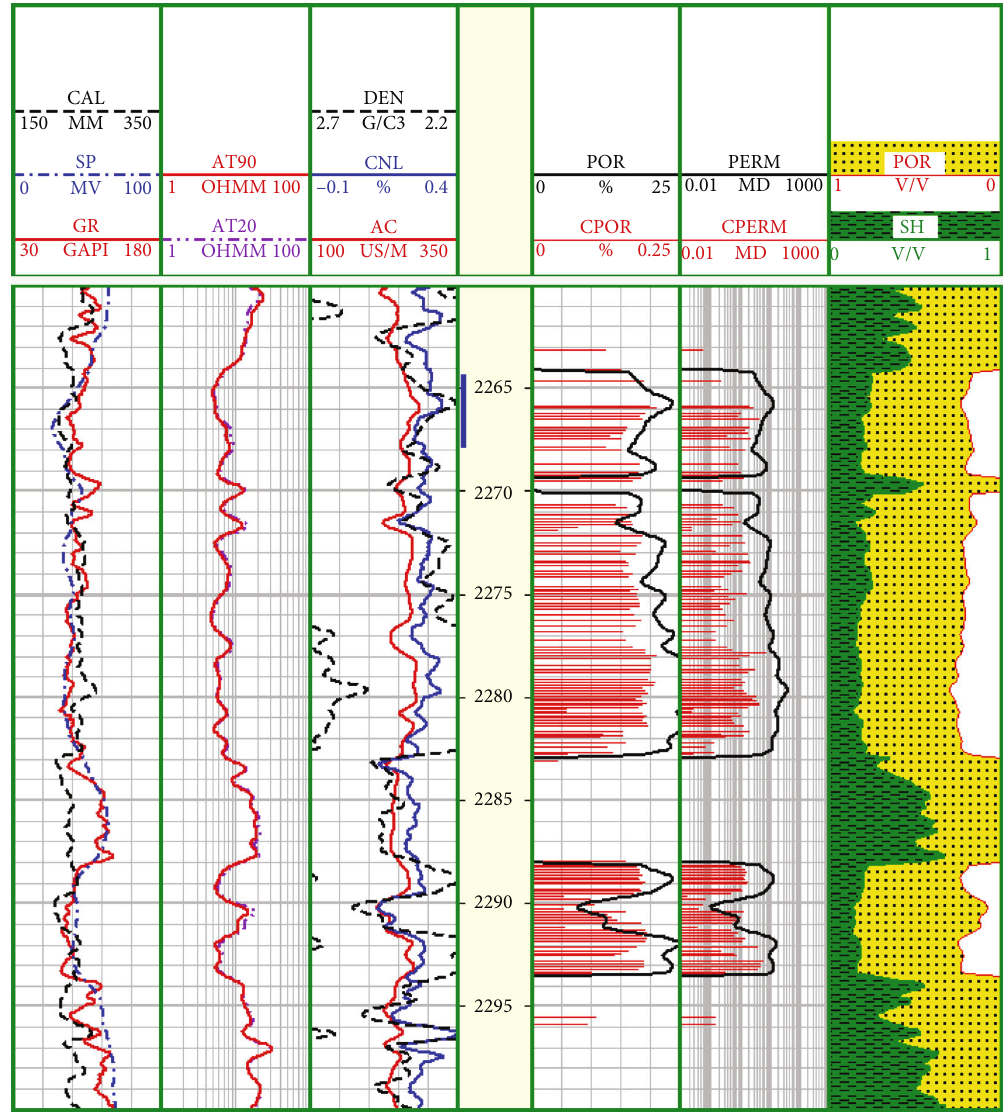
Figure 5: Oil layers in Well M2. The resistivity is about 5 ~ 8 Ω ·